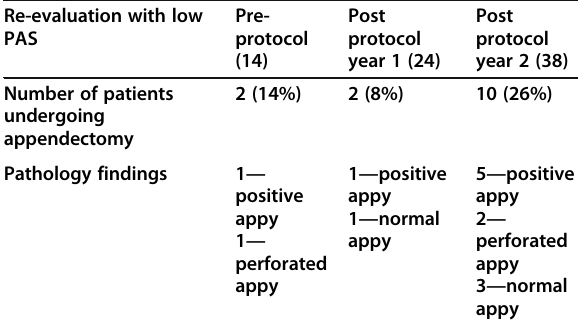
Table 7 Re-evaluated patients with low